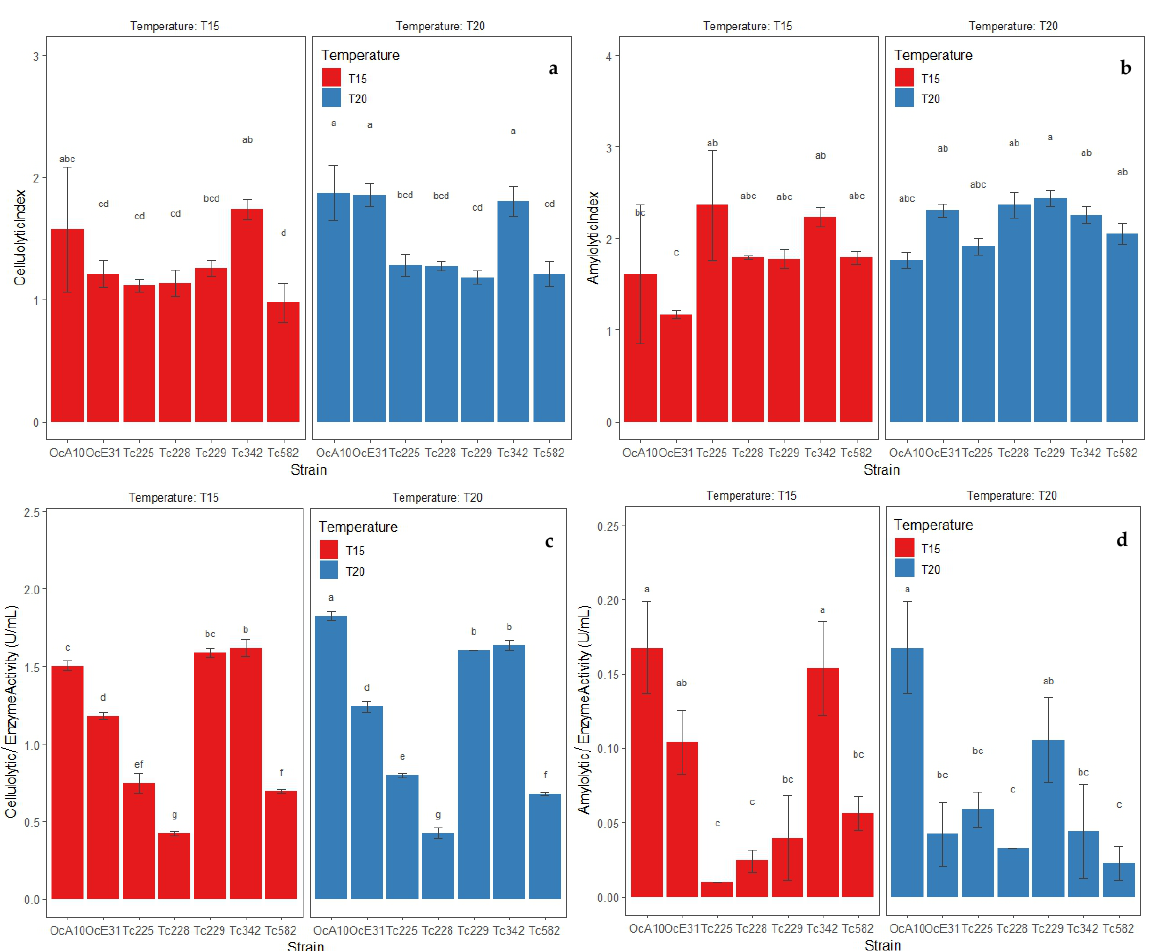
Figure 3. Metabolic activities by extracellular enzymes of bacterial strains isolated from CMCP and OPF at 15 and 20 °C. ( a ) Cellulolytic index (CI) of bacterial strains cultivated in 1% CMC medium, ( b ) amylolytic index (AI) of bacterial strains cultivated in SA medium, ( c ) enzyme activity in bacterial strains cultivated in 1% CMC broth, ( d ) enzyme activity in bacterial strains cultivated in starch broth. Data presented with means ± standard deviation. Different letters indicate significant differences in the parameters ( ρ ≤ 0.05) according to Tukey’s